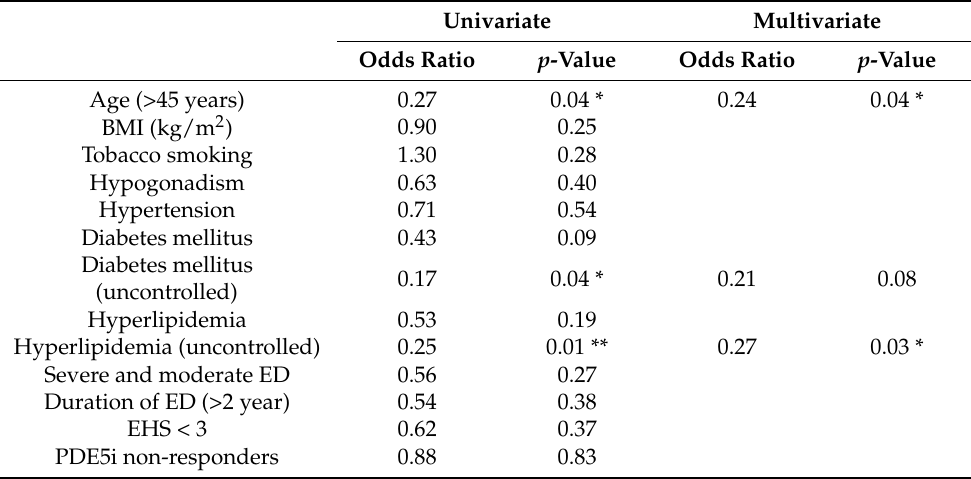
Table 3. Negative predictors of Li-ESWT efficacy in our Taiwanese cohort (n = 69).